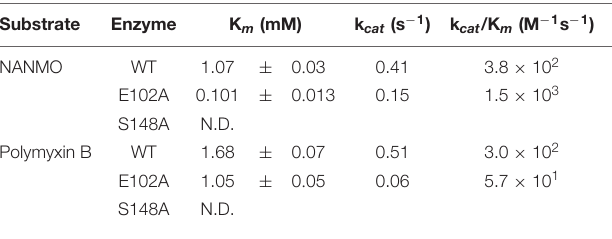
TABLE 1 | PA3944 wild-type and mutant kinetic parameters toward NANMO and polymyxin B.